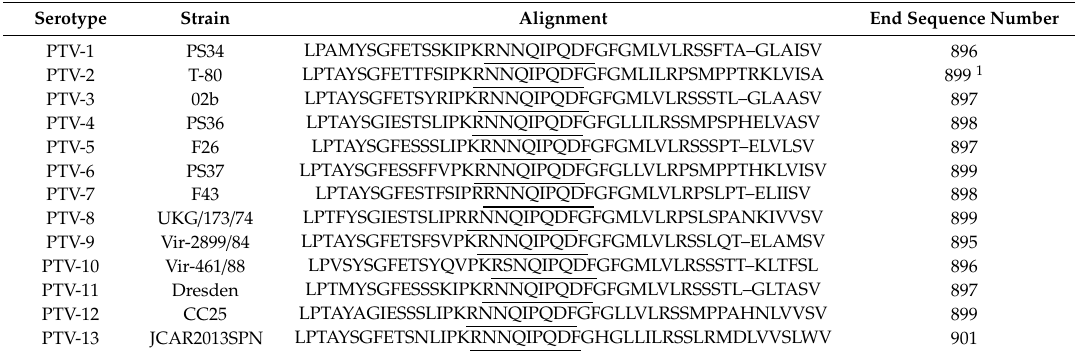
Table 3. Protein sequence alignment of the GH loops of the capsid proteins from the 13 serotypes of